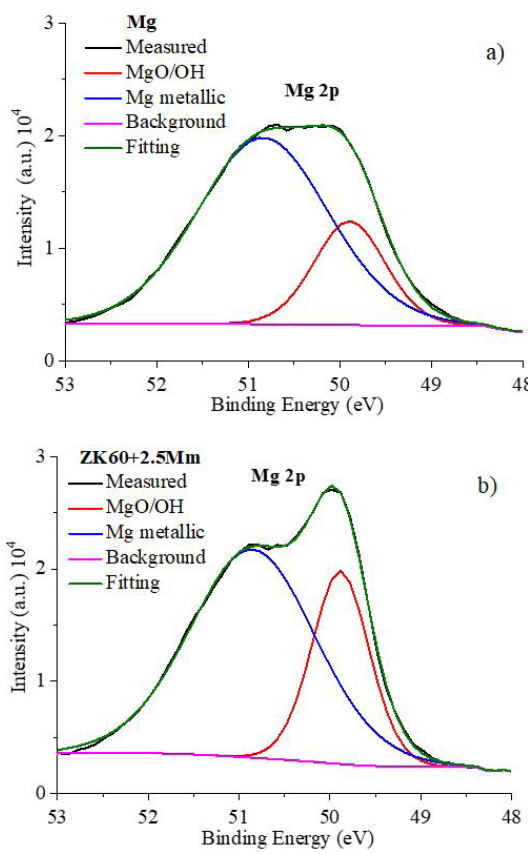
Figure 6. XPS spectra of Mg-2p peak for ( a ) pure Mg and ( b ) ZK60+2.5 Mm alloy after ECAP+LTR processing